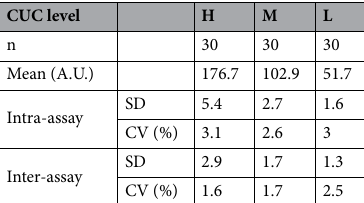
CUC level H M L n 30 30 30 Mean